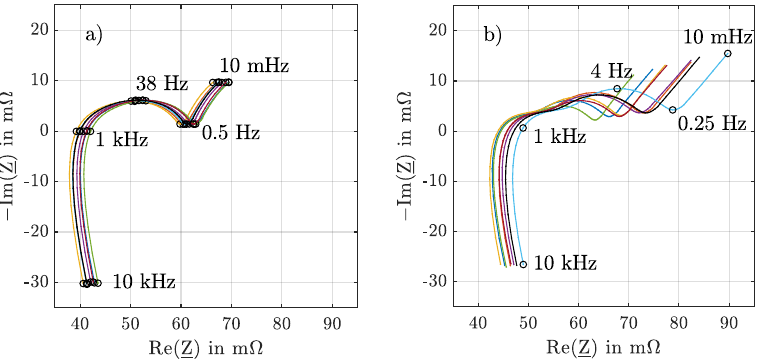
Figure 5. Impedance spectra at 25 °C and 50% SoC of all 8 cells ( a ) before and ( b ) after 174 cycles shown in a Nyquist